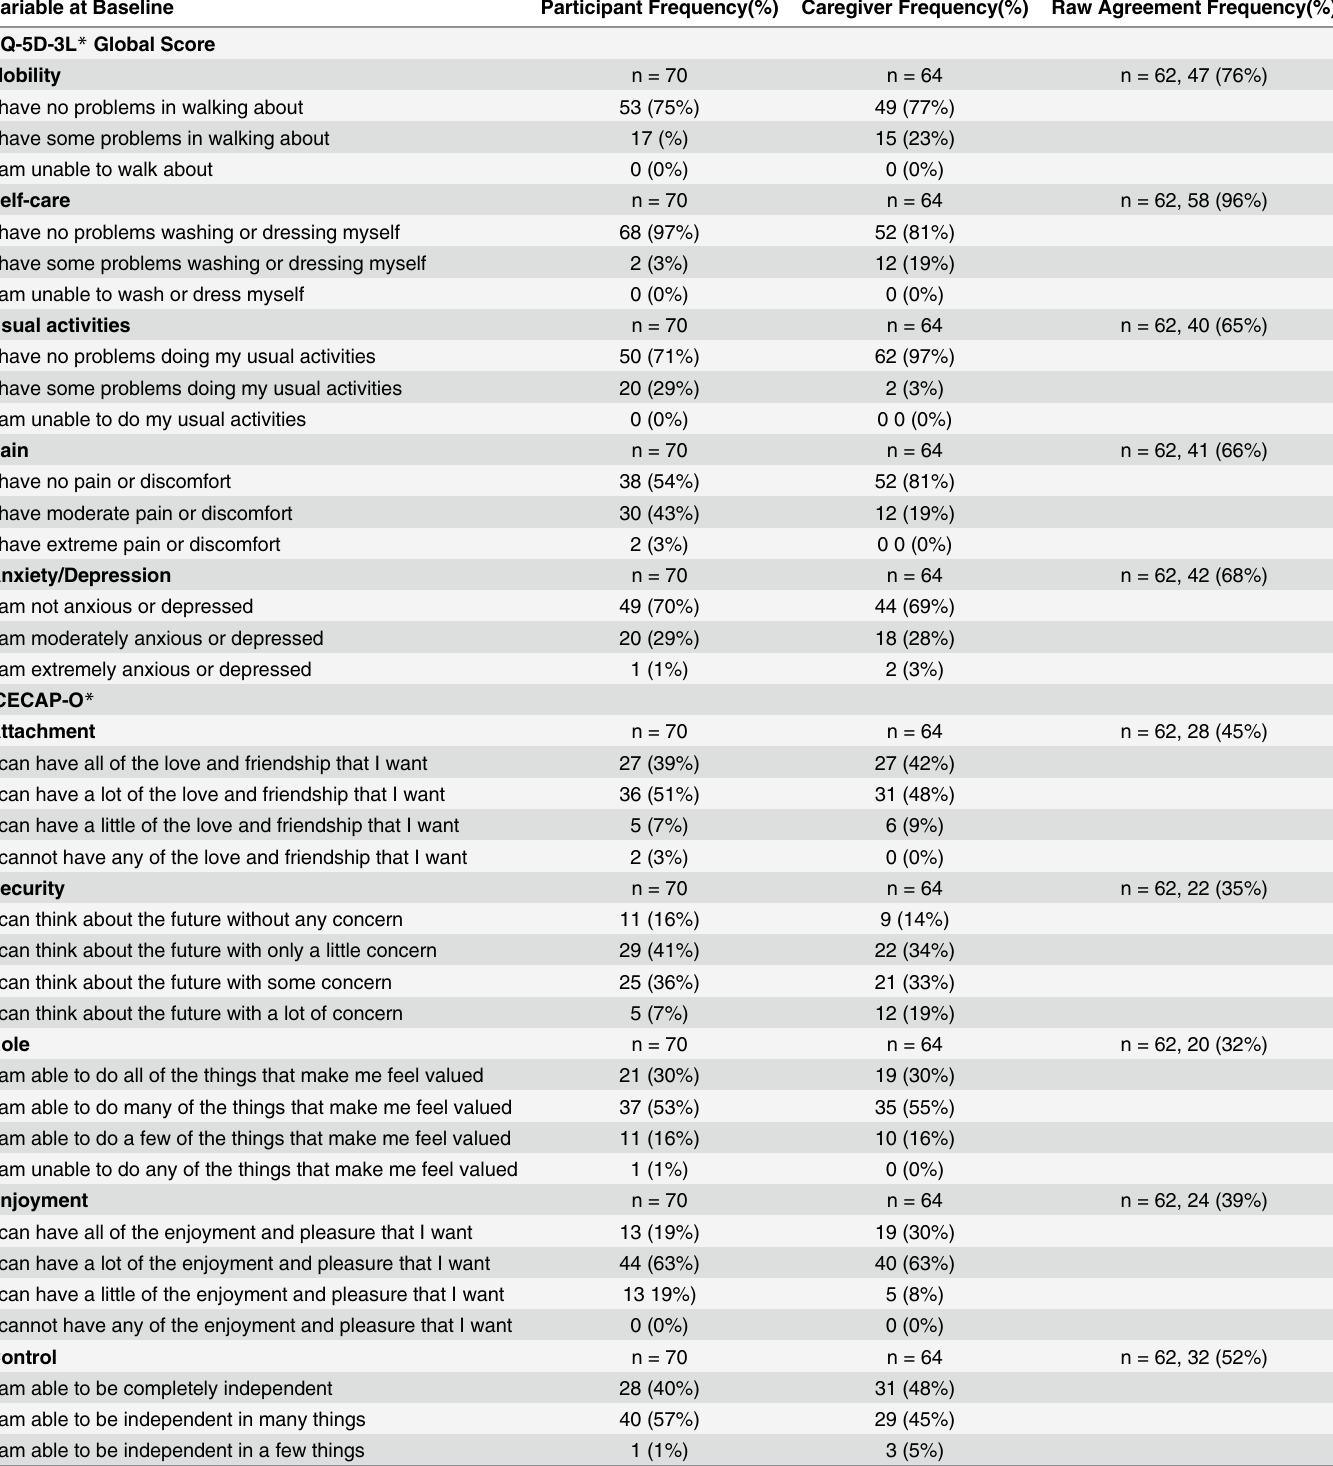
Table 2. Distributions of Individual Domains of the EQ-5D-3L and the ICECAP-O. Variable at